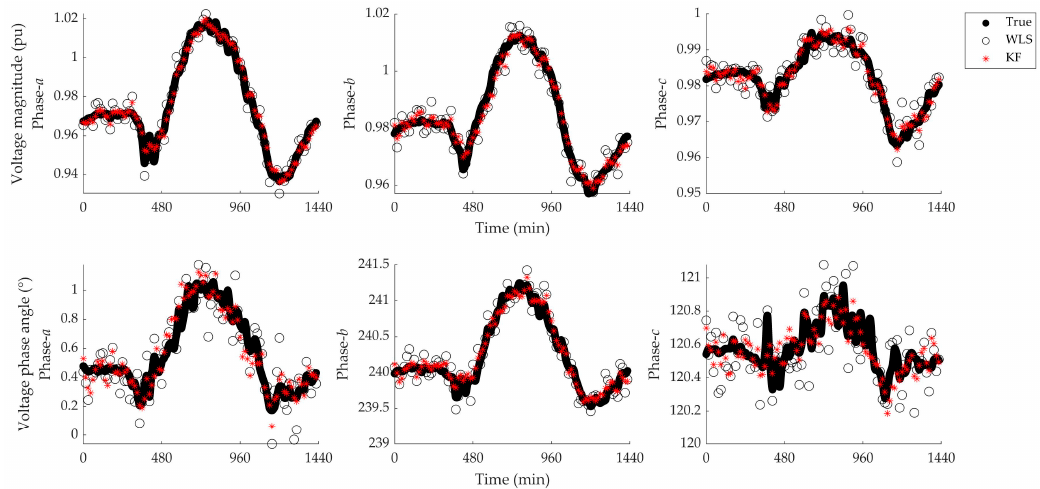
Figure 7. Estimated state values at bus 142.